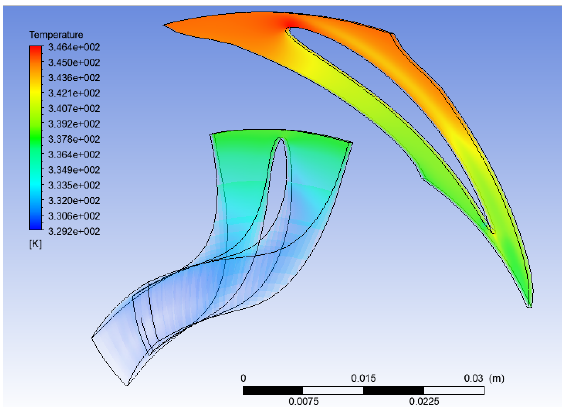
Figure 25. CFD study results: Temperature (R245fa).